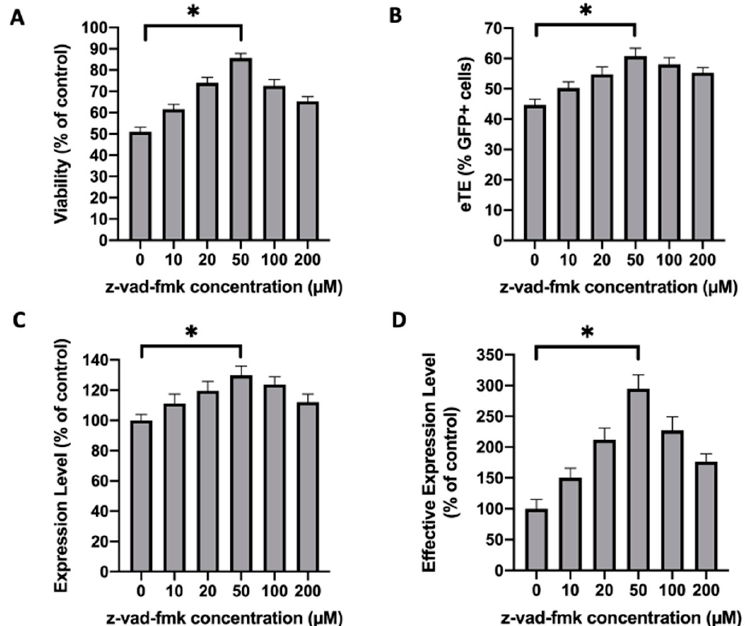
Figure 5. Effects of caspase inhibitor on cell viability and EGFP expression in NIH/3T3 cells. The experimental condition was similar to that in Figure 1, except that NIH/3T3 instead of Jurkat cells were used in the experiment. ( A ) Cell viability; ( B ) eTE; ( C ) expression level; ( D ) effective expression level. Pulsing condition: 650 V/0.2 cm, 400 µs, 1 pulse. Error bars, SEM; * p < 0.05, Student’s t -test. N = 6.